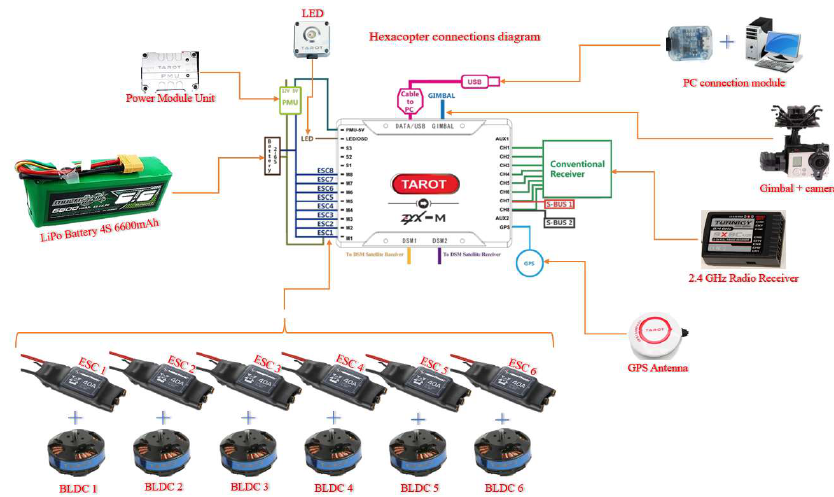
Figure 4. Connections diagram for hexacopter variant v1.